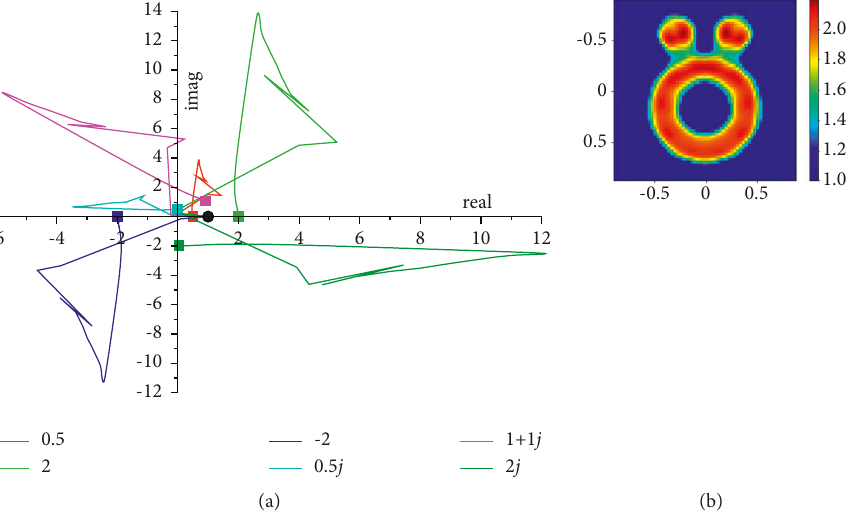
� 2 with the calibration factor α � 1 in inversion stage, with E r � 0.5. (b) E � 1.5. (c) E � 2. (d) E �− 2 j . in in in in